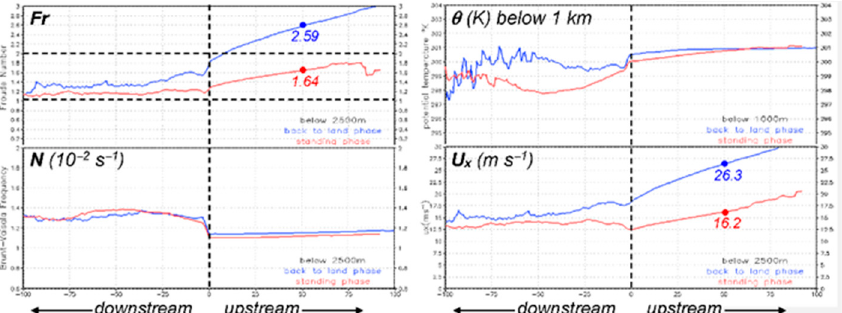
Figure 13. Mean values of Fr , N (10 − 2 s − 1 ), and horizontal wind component parallel to section plane ( U x , m s − 1 ) below 2.5 km and θ below 1 km, computed from 100 km downstream to 100 km upstream (abscissa, km) and averaged through time for all VCSs during the standing phase (red) and retreating back to land phase (blue) in A2. The rainband was placed at the origin of x -axis (dashed line), and Fr values of 1 and 2 (dashed) and Fr and U x at 50 km upstream (dots) are marked.